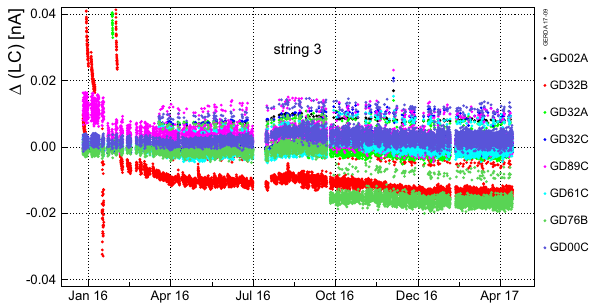
Fig. 20 Changes of leakage currents Δ (LC) of indicated detectors of string 3 in the period from December 2015 to April 2017. For the other detector strings the corresponding data are shown in Fig. 34 of the